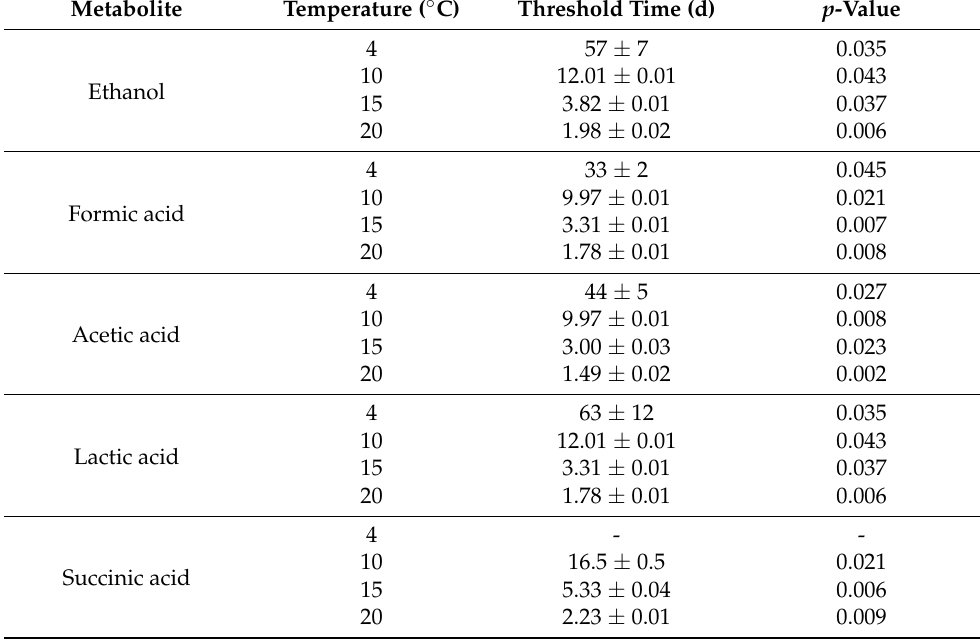
Table 2. Time until a significant change in metabolite concentration was observed (“threshold time”). Shown is mean ± standard deviation of threshold time points and p -value of comparison between the concentration at the threshold time point and the initial concentration at each storage temperature.